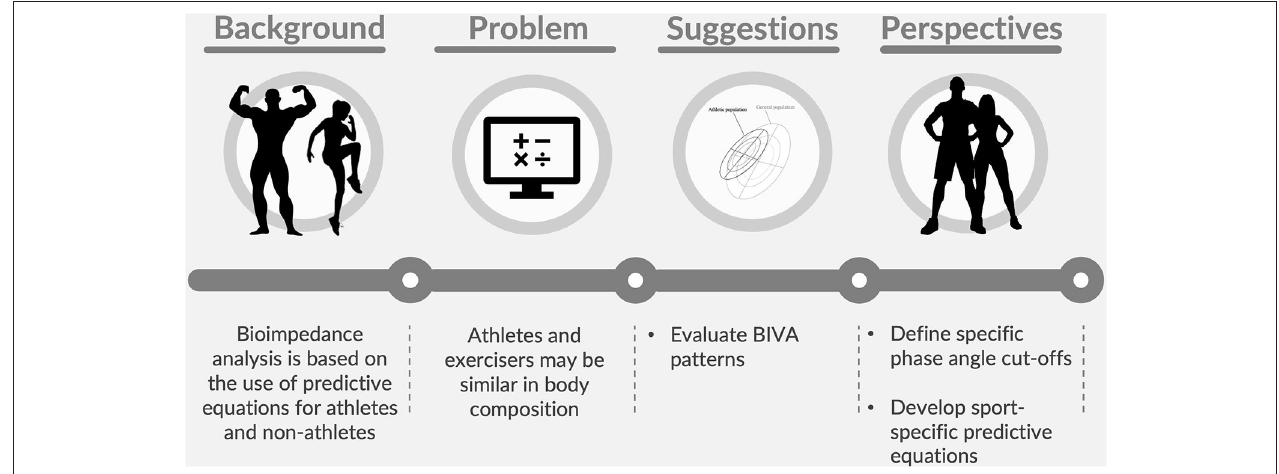
FIGURE 1 | The schematical representation of the problem, proposed solutions, and future perspectives related to the body composition assessment in